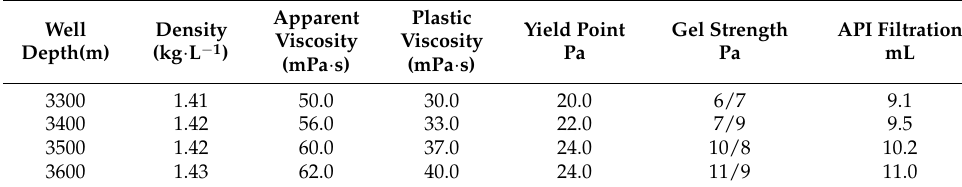
Table 10. Comparison of drilling fluid rheology at different depth.